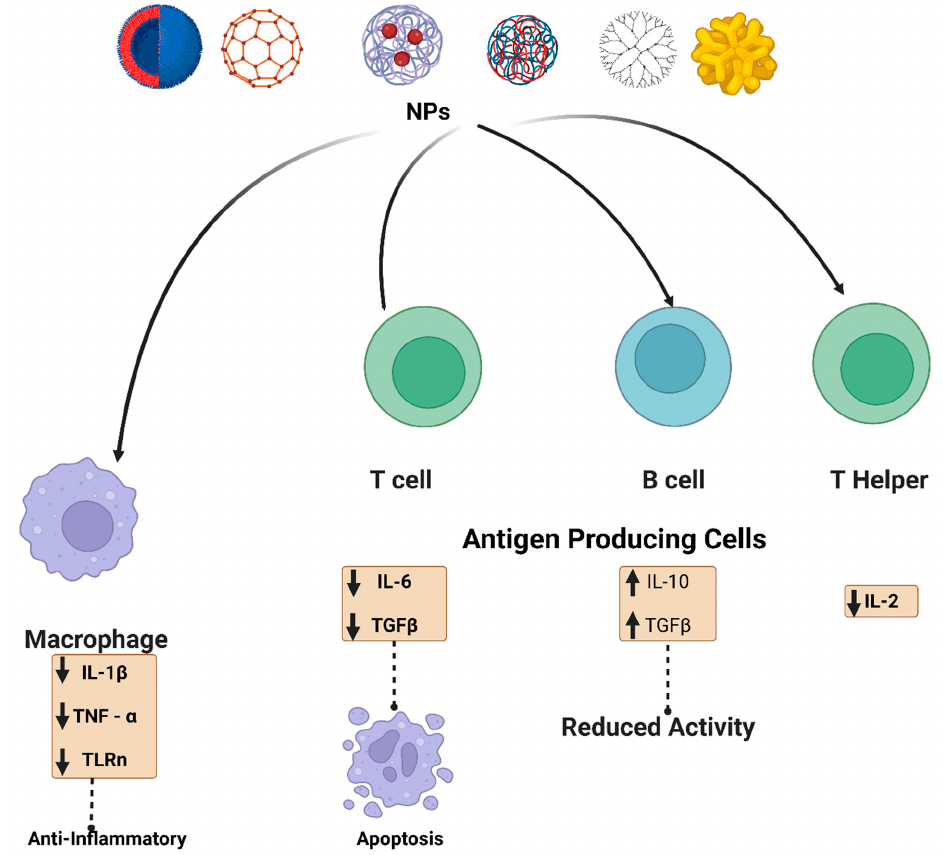
Figure 3. Schematic illustration of the NPs interaction and effect on the immune system. NPs (metalic, polymeric, dendrimer, carbon-based and lipid-based) interact with immune cells such as antigen-presenting cells, B cells, T cells, and macrophages. For example, carbon-based nanomaterials are involved in up-regulation of transforming growth factor (TGF- β ), interleukin-10 (IL-10), and it also decreased B cell activity in addition to apoptosis. Metal oxide NPs have also been reported to affect adaptive immune cells, such as cerium oxide NPs, which are responsible for scavenging reac- tive oxygen species (ROS). Polymeric NPs and dendrimers exhibit an assortment of immunosup- pressive effects. Some possible mechanisms by which various nanoscale compounds might dampen the immune system are illustrated.